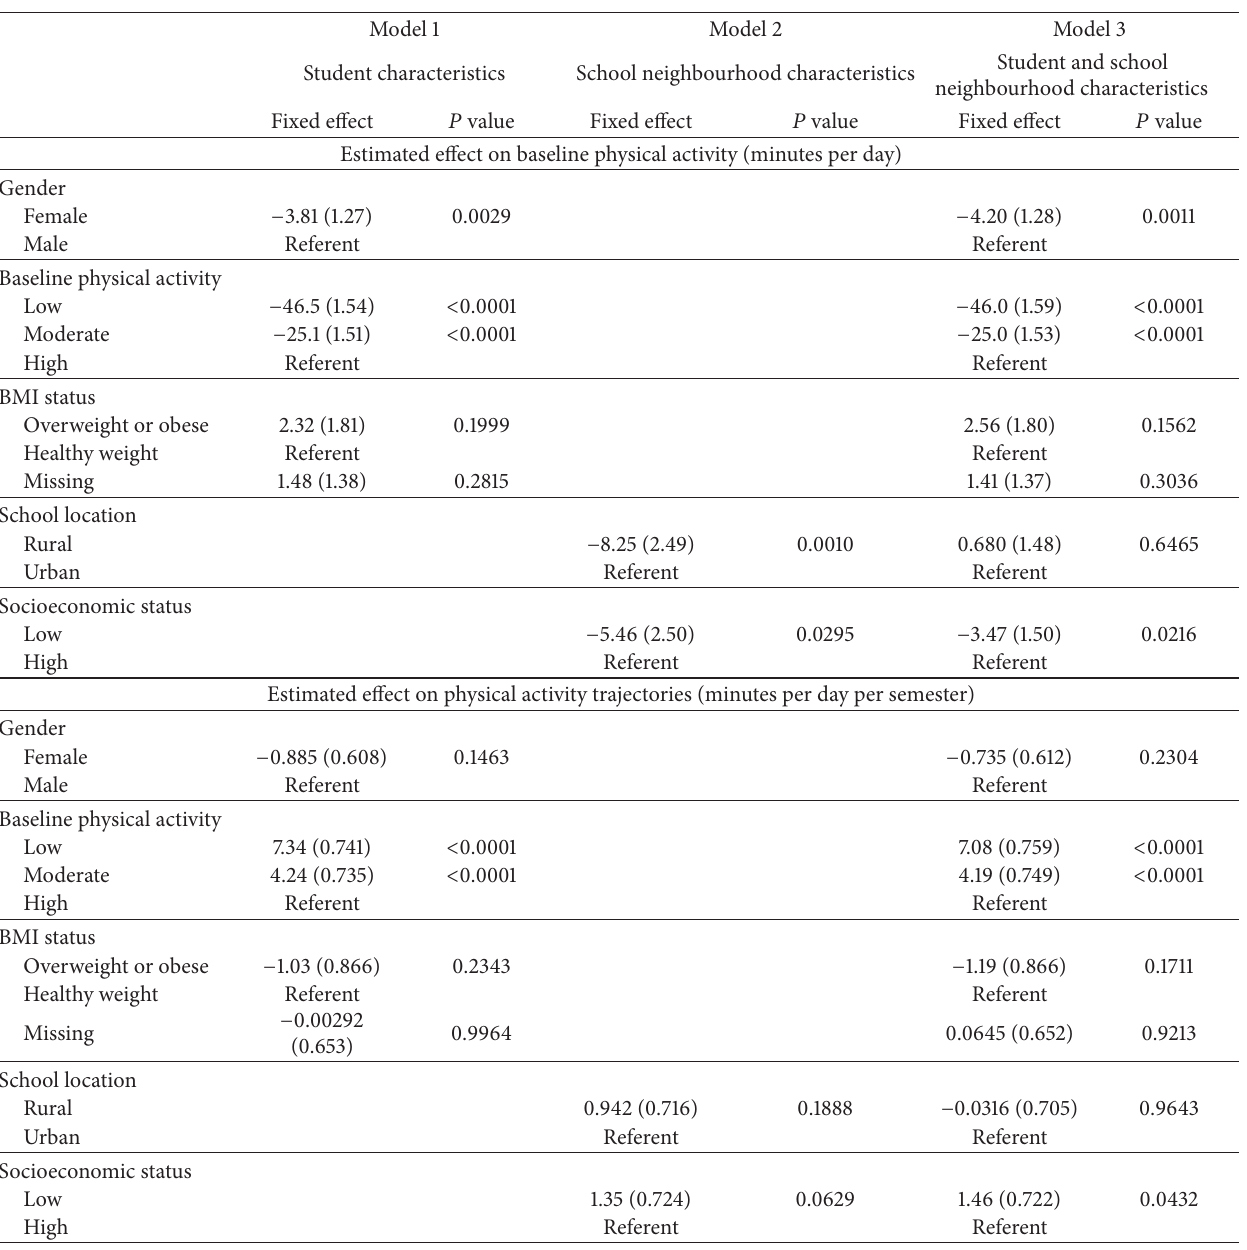
Table 4: Multivariate growth curve modeling examining estimated effect on students’ baseline physical activity and physical activity trajectories when adjusted for student and school neighbourhood characteristics.